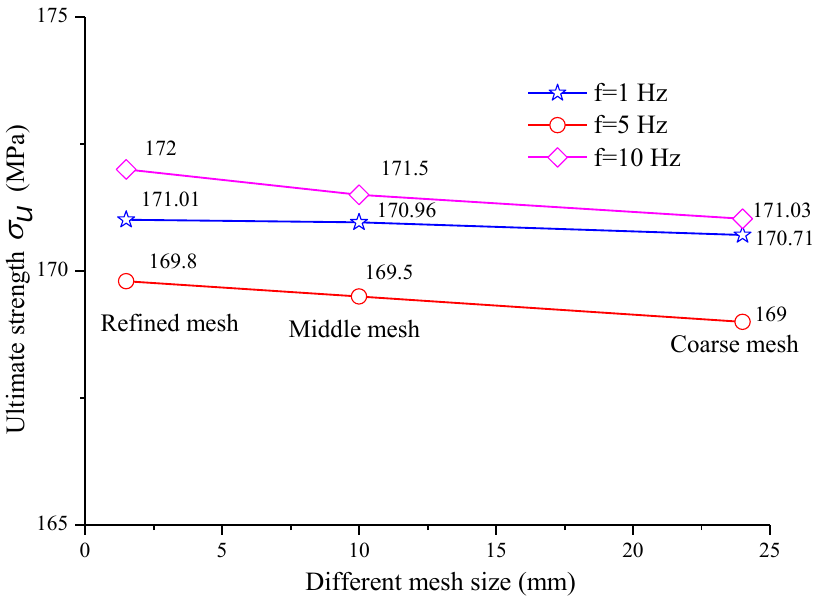
Figure 5. The time and mesh convergence analysis.